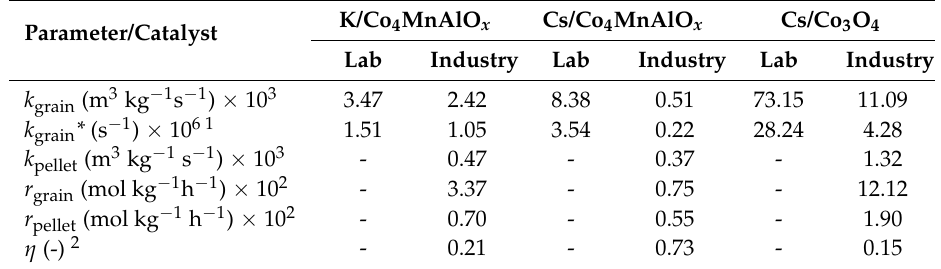
Table 1. Kinetic constants and reaction rates of N 2 O catalytic decomposition over laboratory (grain form) and commercially prepared (grain and pellet forms) catalysts and estimated internal